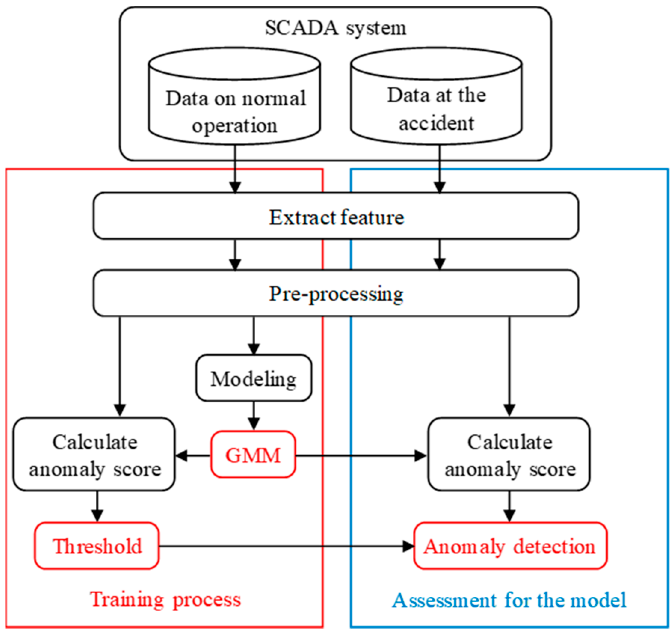
Figure 1. Process of training and assessment.